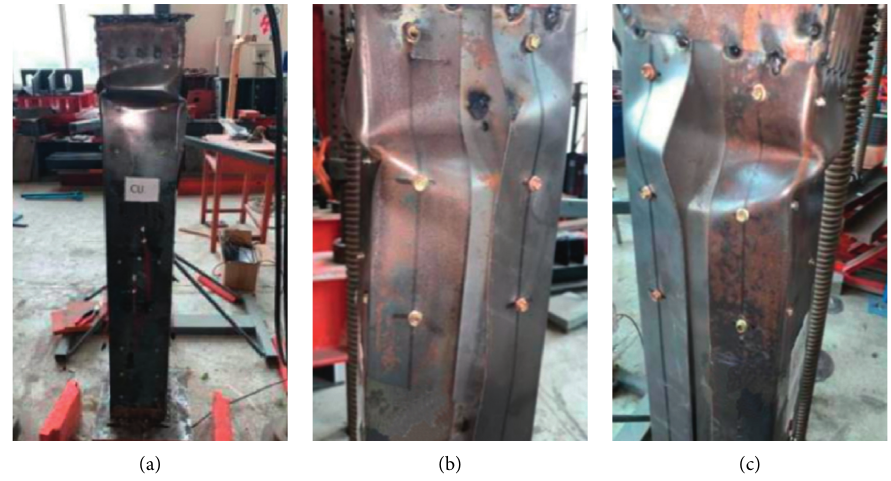
Figure 18: CU-2 failure mode: (a) south, (b) east, and (c) west.